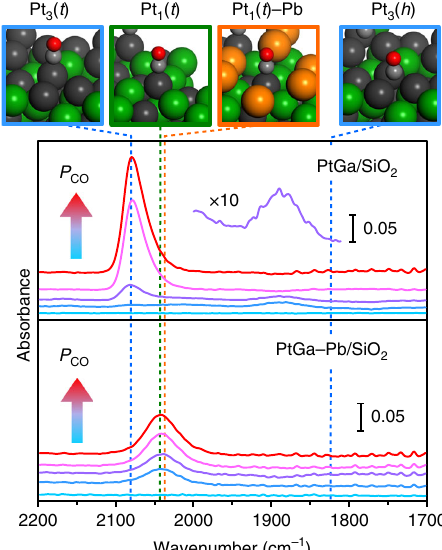
Fig. 3 Surface characterization by FT-IR with CO adsorption. Changes in FT-IR spectra of CO adsorbed on PtGa/SiO 2 and PtGa – Pb/SiO 2 (Pt/Pb = 2) with increase in P CO measured at − 196 °C are shown. Vertical dashed lines indicate ν C = O values calculated by DFT. The upper pictures show the optimized structures of on-top CO ( t ) on Pt 3 , Pt 1 , and Pt 1 – Pb sites, and threefold CO ( h ) on Pt 3 hollow site.